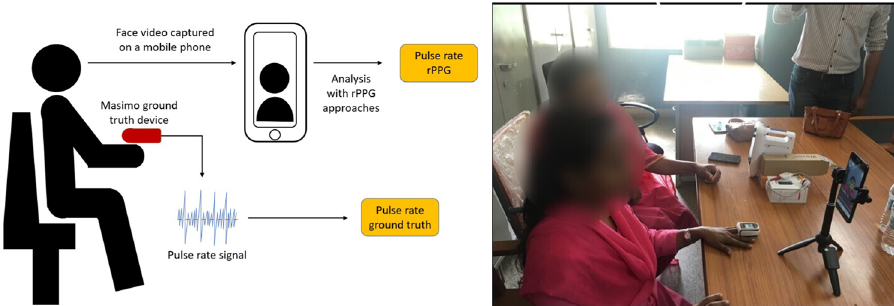
Fig. 2 Experimental setup used for data collection. The graphical representation of the data collection process for rPPG approaches (mobile phone video) and the contact-based ground truth PPG (Masimo device) is shown in the left fi gure. The right fi gure depicts the actual data collection process showing the positioning of the ground truth Masimo device on the left hand and the subject facing the mobile phone camera in an upright position (faces blurred to maintain anonymity).